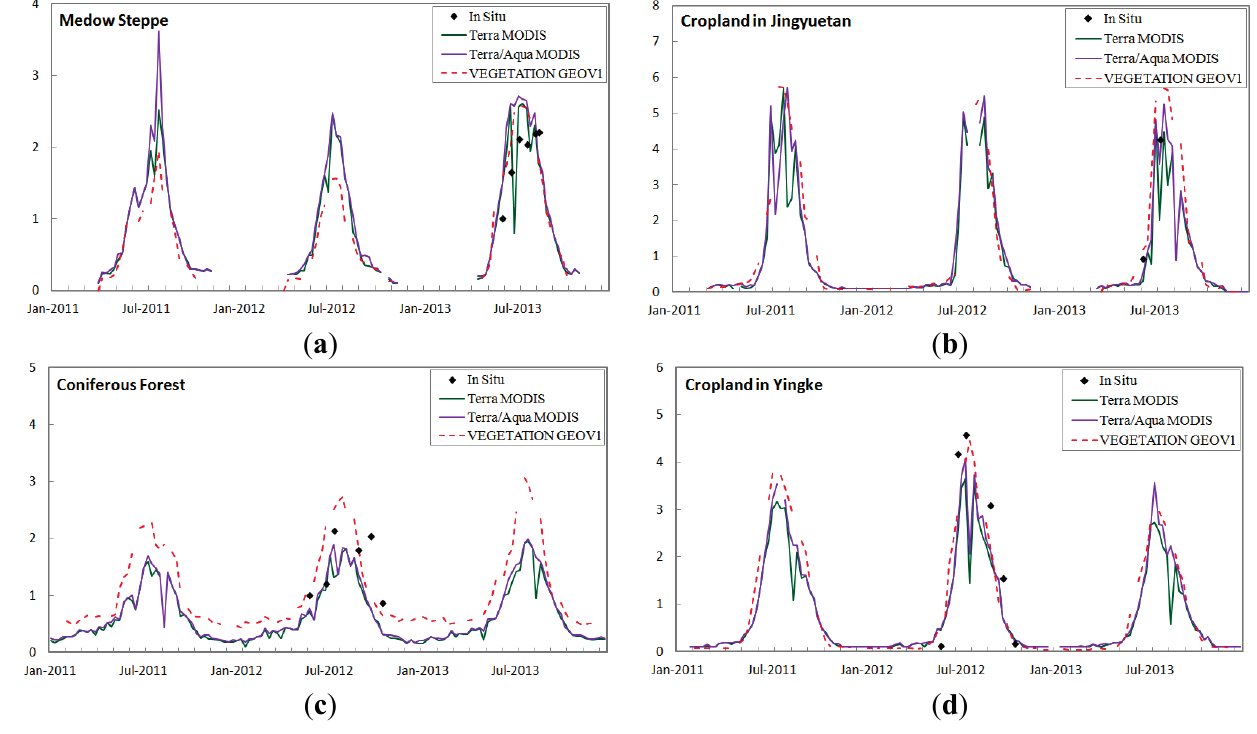
Figure 5. Inter-annual and seasonal variations generated by the LAI products for 2011–2013: ( a ) meadow steppe; ( b ) cropland in Jingyuetan; ( c ) conifer forest; and ( d ) cropland in